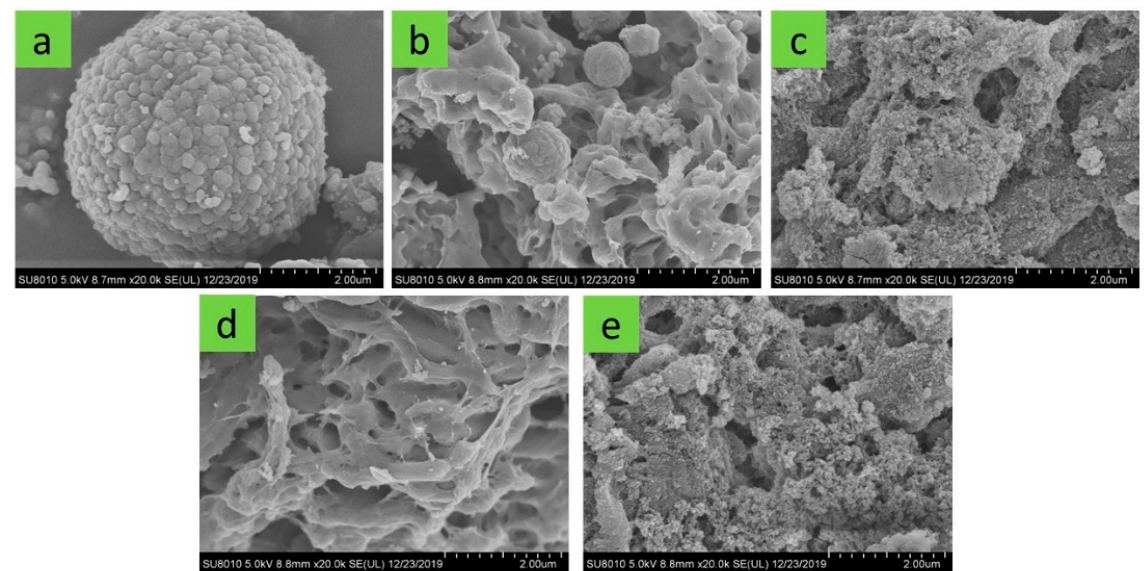
Figure 3. SEM images of different hydrochars. ( a ) S10C0; ( b ) S5C5; ( c ) S5C5N and ( d ) S0C10 before adsorption; ( e ) S5C5 after adsorption.